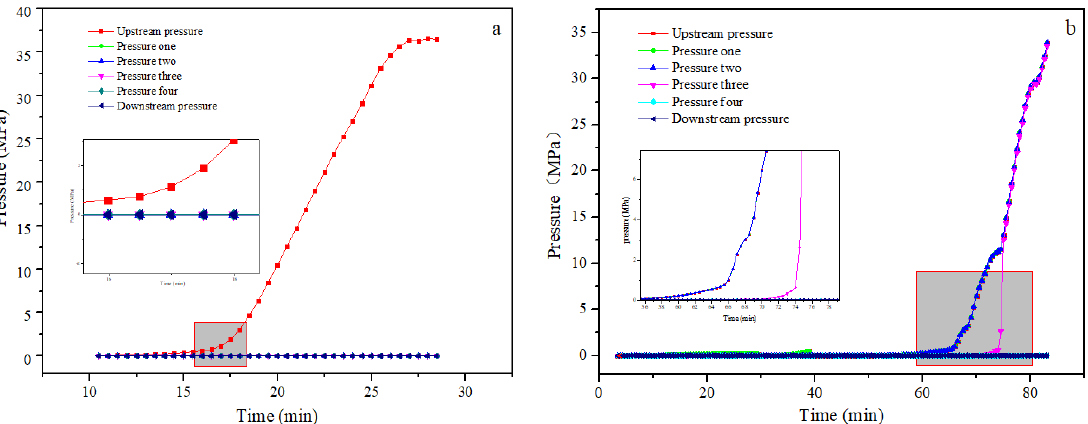
Figure 11. Experimental curves of forward breakthrough ( a ) and reverse breakthrough pressure ( b ).